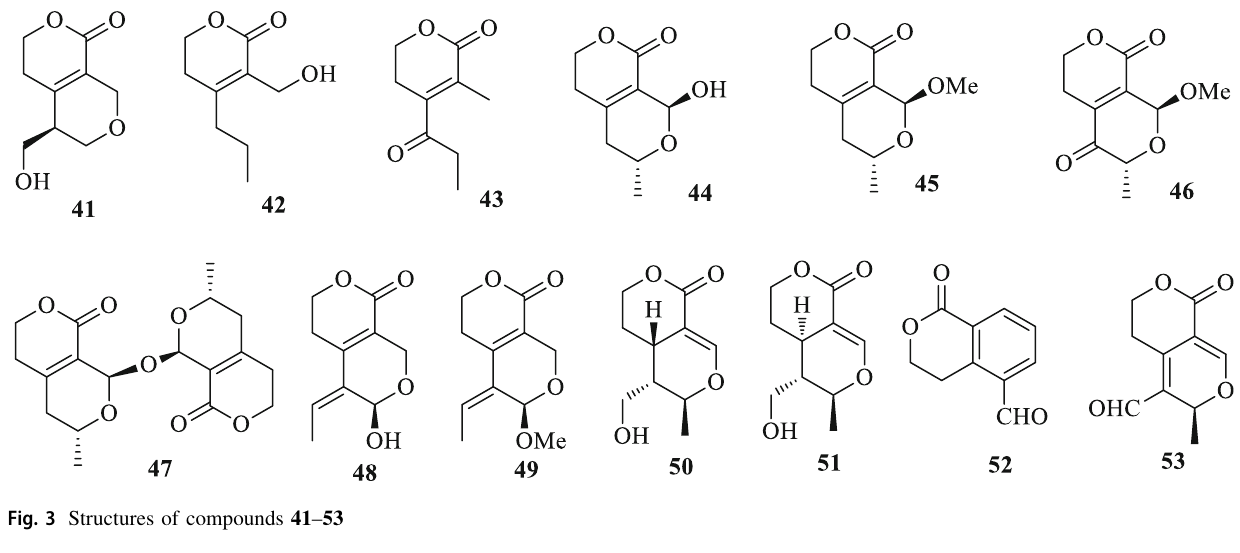
Fig. 3 Structures of compounds 41 – 53